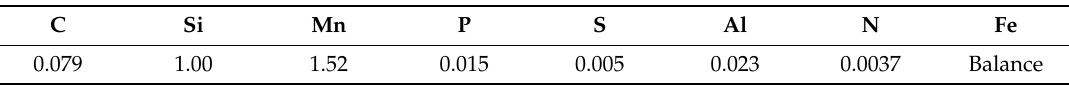
Table 2. Chemical compositions of zinc coated * duplex steel (in wt